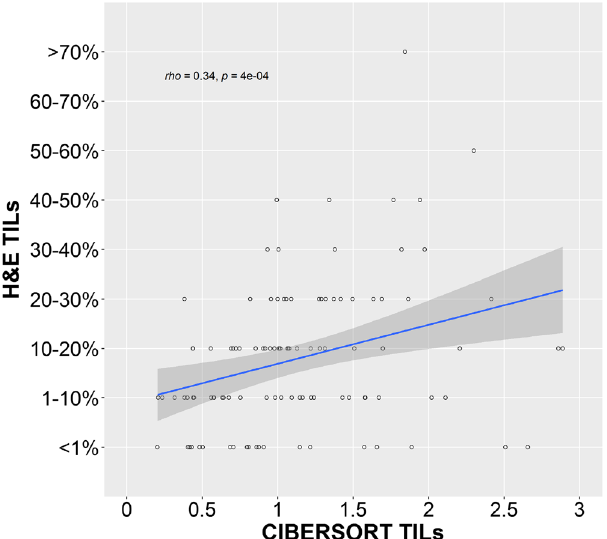
Figure 2. Correlation between H&E scored and CIBERSORT scored TILs in TCGA TNBC cases. Comparison of H&E scored and CIBERSORT scored TILs in TCGA TNBC cases (n = 103) showed a Spearman rank correlation coefficient of 0.34 with a pvalue of 0.0004. The CIBERSORT score consists of arbitrary units that reflect the absolute proportion of immune cells in a mixture. A higher score would indicate a higher proportion of immune cells. Image generated with R 4.0.2 (https ://www.R-proje ct.org) 35 .